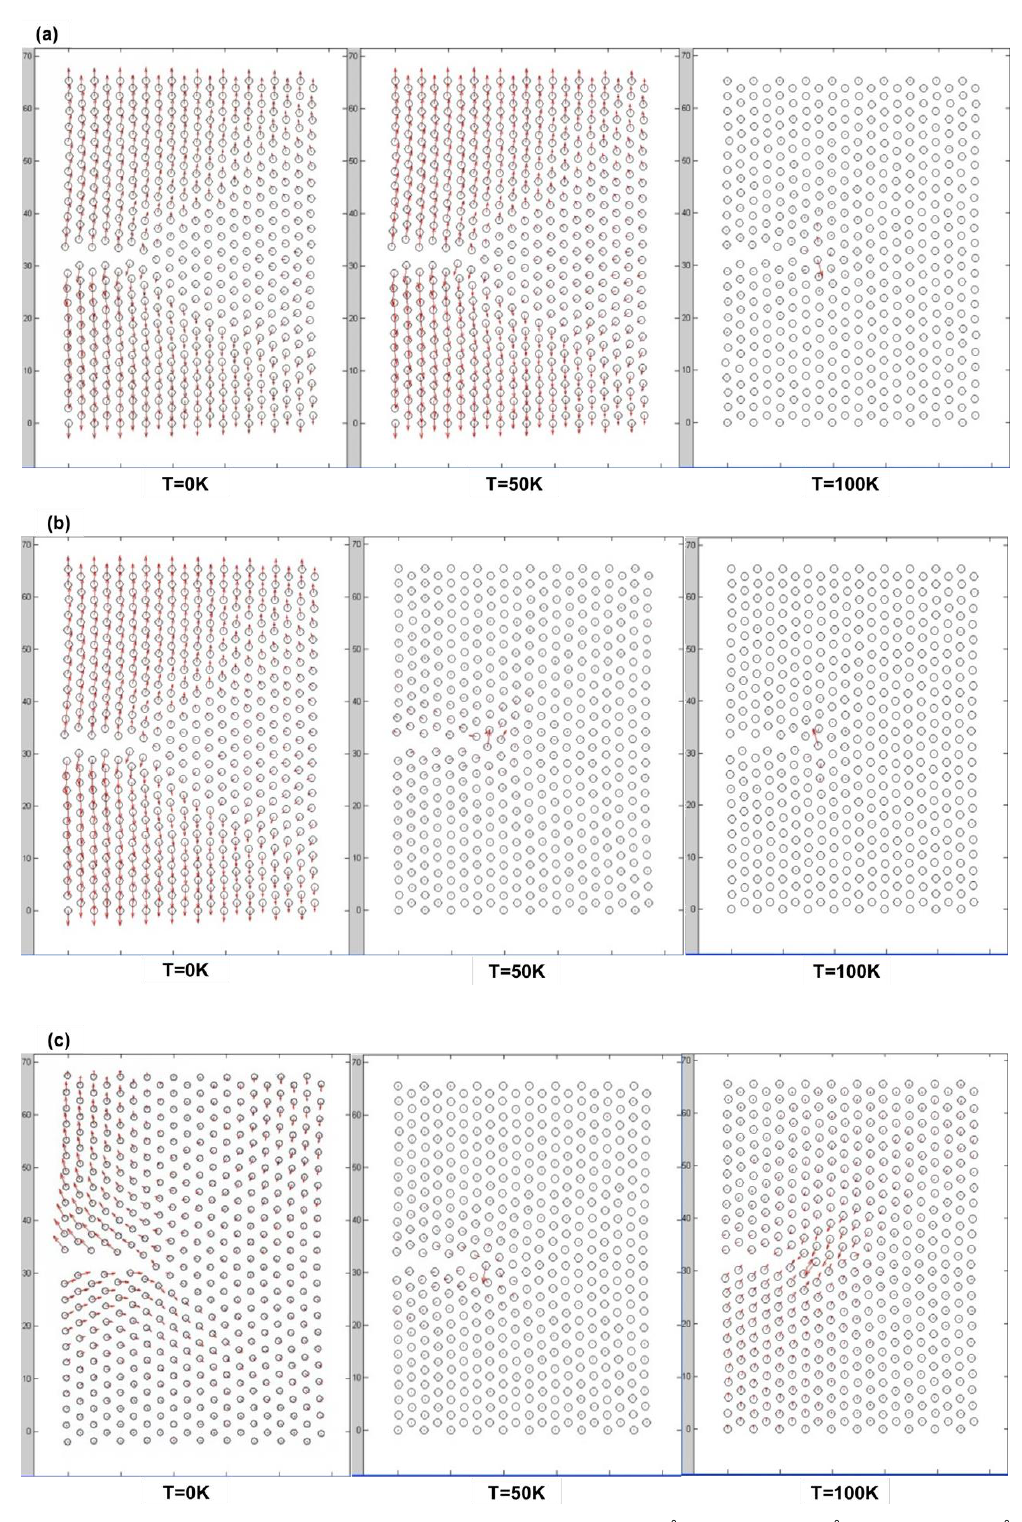
Figure 4. Atomic structure at tensile displacement of ( a ) δ yy = 2.46 Å. ( b ) δ yy = 2.65 Å. ( c ) δ yy = 2.754 Å at different temperatures.